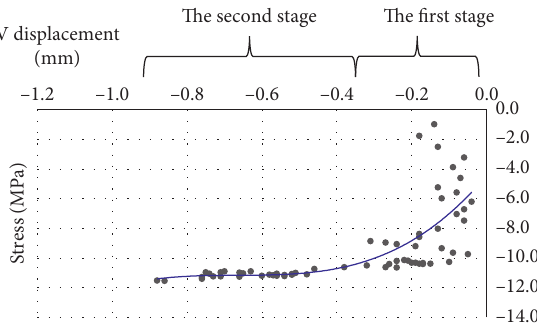
Figure 10: Plot of stress versus beam end displacement of the point 6 on the eastern column.